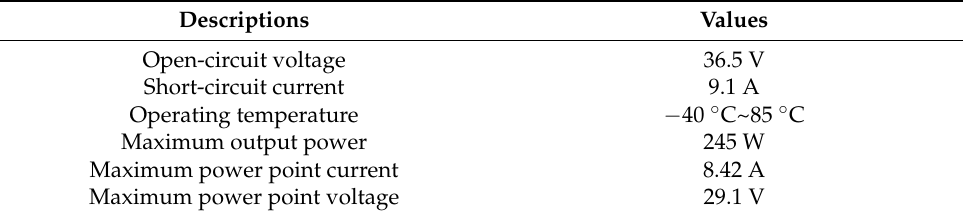
Table 2. Technical parameters of PV arrays.